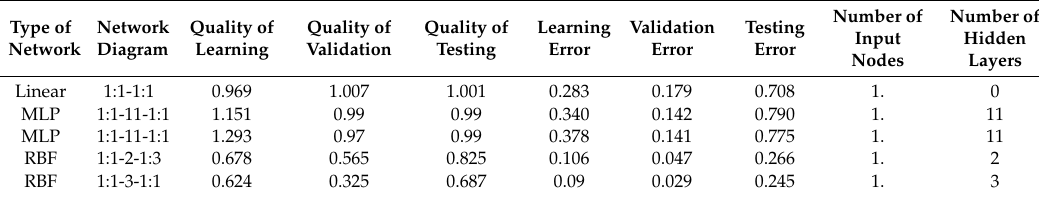
Table 1. Characteristics of Five Generated Neural Network Models for the Variant of Contamination in Wheat Grain Weight [Own Source].